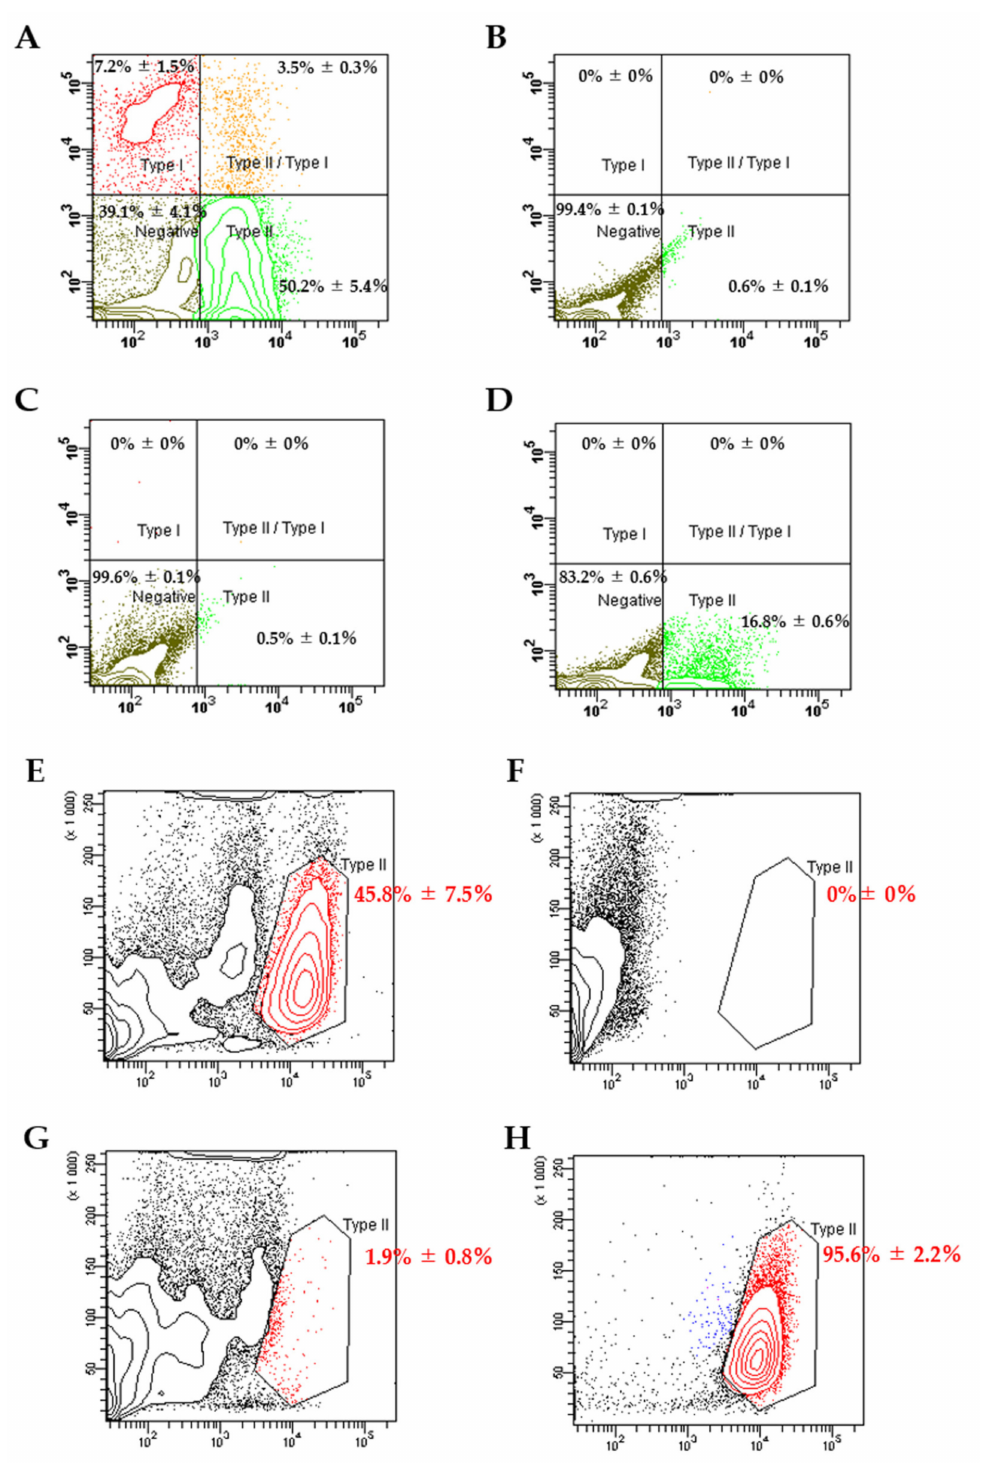
Figure 2. Flow cytometry analysis of extracted lung cells ( A – D ) and ATII cell isolation ( E – H ). ( A ) Representative flow cytometry analysis of RT1-40 and RT2-70 expression. ( B ) Unstained control. ( C ) Isotype control against RT1-40. ( D ) Isotype control against RT2-70. Nonspecific binding was observed in the isotype control against RT2-70. ( E ) Representative flow cytometry analysis of ATII cell sorting. ( F ) Unstained control. ( G ) Isotype control. ( H ) Data after ATII cell sorting. All data represent means ± standard